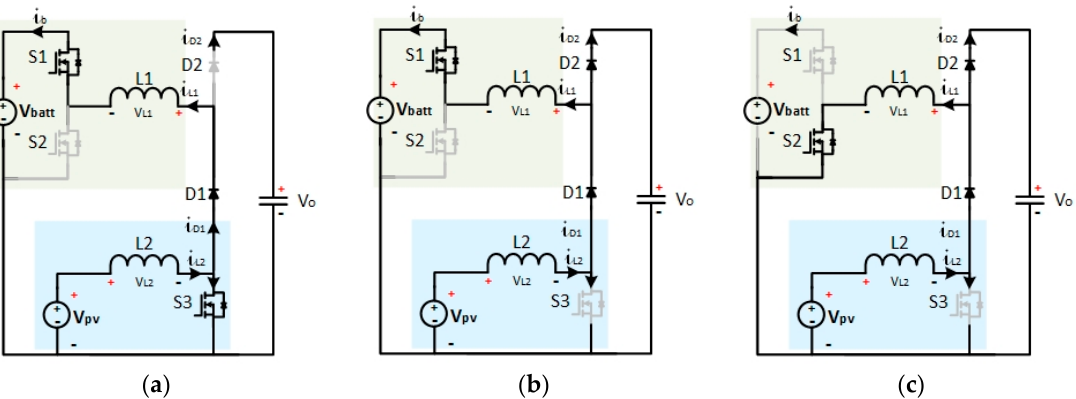
Figure 4. Current flow paths for operating stages in single input double output mode: ( a ) Stage I; ( b ) Stage II; and ( c ) Stage III. 1.